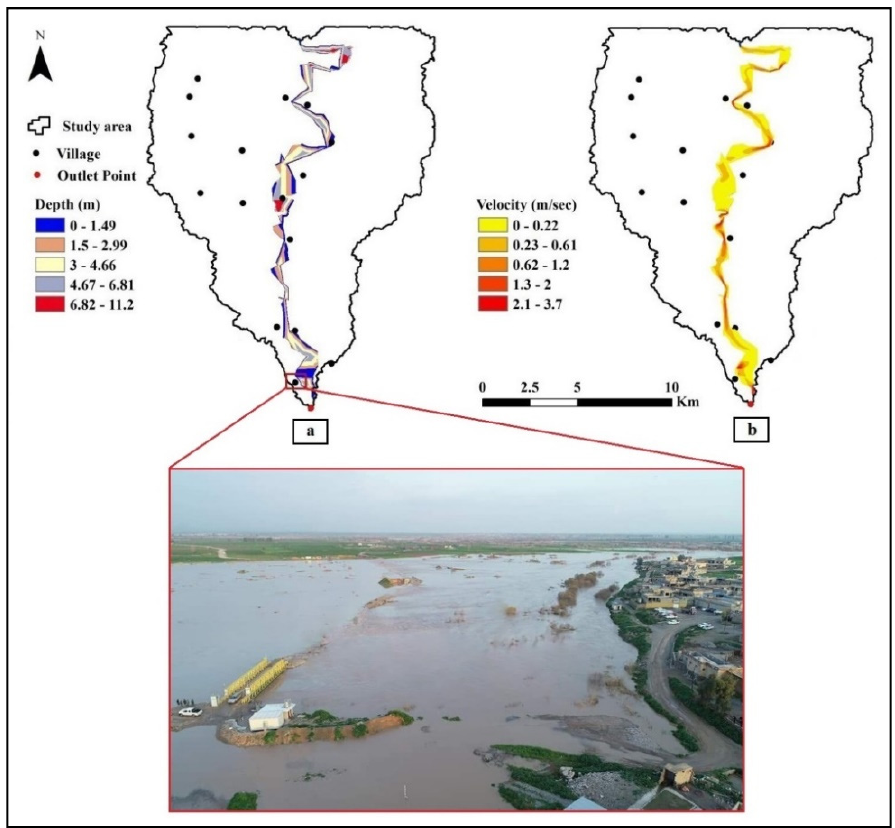
Figure 13. ( a ) Floodplain depths map; ( b ) Water current velocity map.